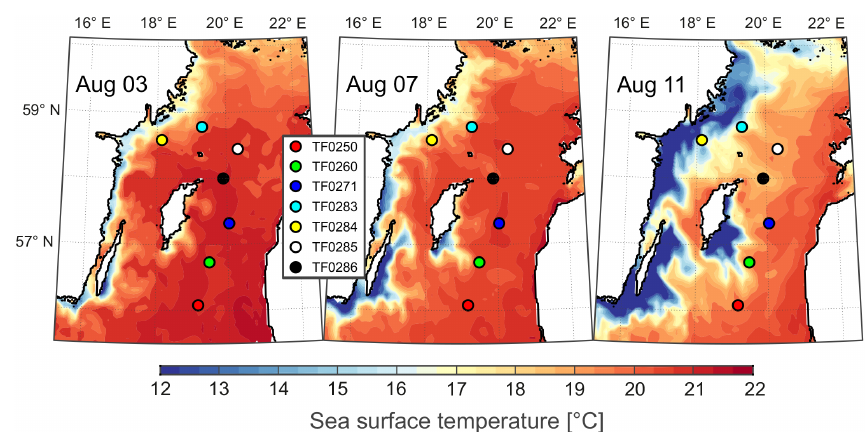
Figure 4. Development of sea surface temperatures in the central Baltic Sea between 3 and 11 August 2016 using the oceanographic model of Gräwe et al. (2015). The coloured dots represent the sampling stations.